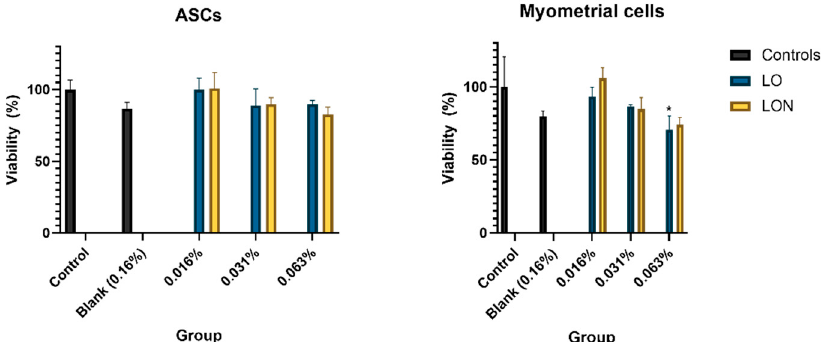
Figure 2. Cell viability evaluated with PrestoBlueTM for ASCs and myometrial cells cultured with and without LO and LONs. The asterisk represents a significant difference ( p < 0.05) from controls. Graphic made with GraphPad Prism 9.0 ( n = 3).